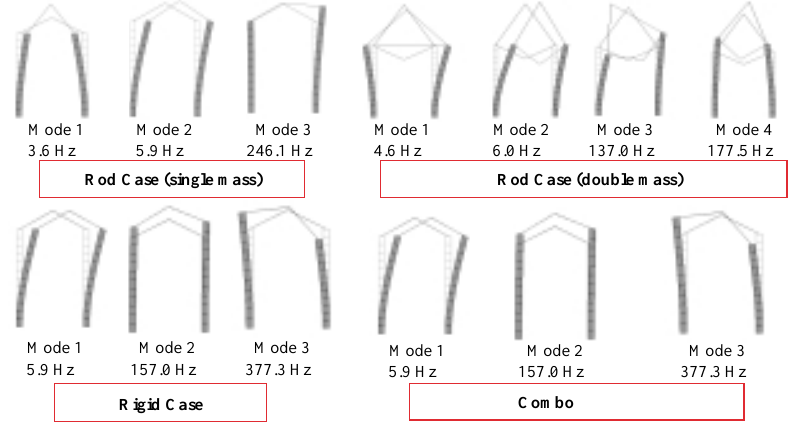
Fig. 13. Mode shapes for symmetric structure and asymmetric mass.